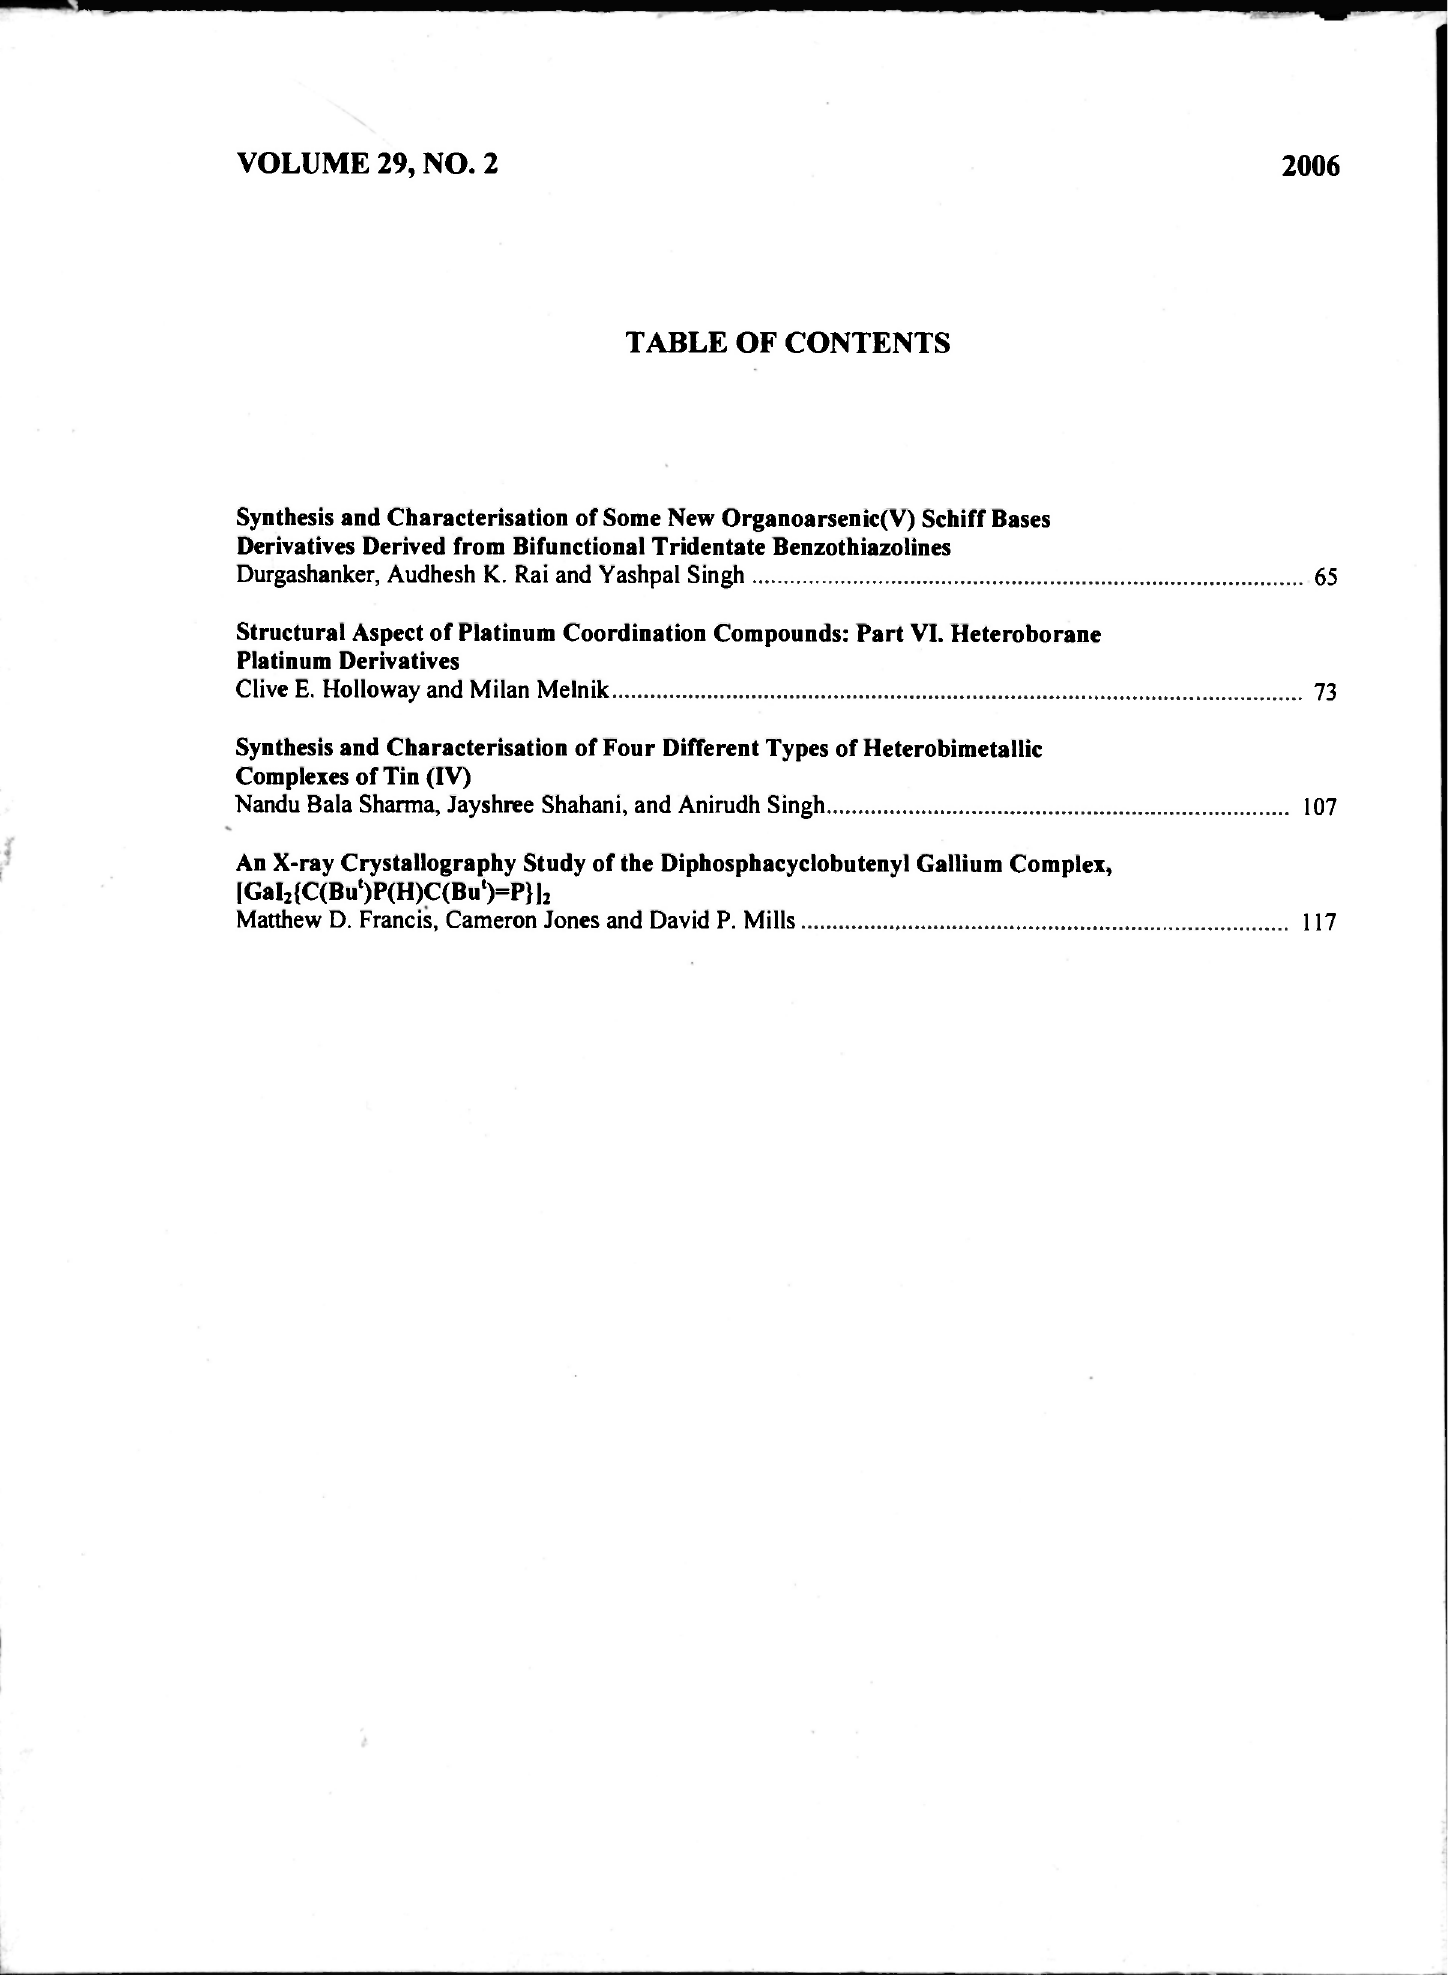
Synthesis and Characterisation of Some New Organoarsenic(V) Schiff Bases Derivatives Derived from Bifunctional Tridentate